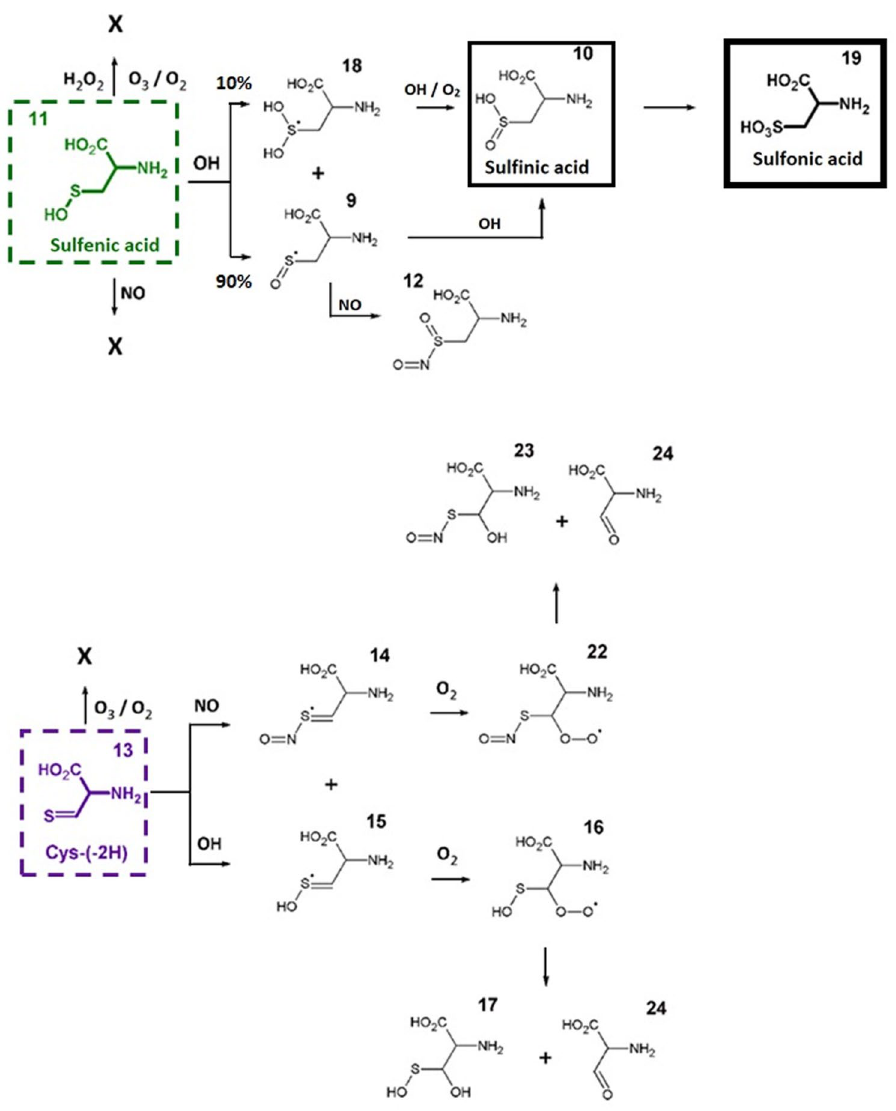
Figure 7. Summary of the predicted reaction paths encountered during the oxidation of sulfenic acid (top) and Cys-(-2H) (bottom). Stable oxidation products (sulfinic and sulfonic acid) are indicated using a solid black box. Branching ratios (compared to the total number of observed reactions) are depicted in cases when multiple reactions products were observed during the